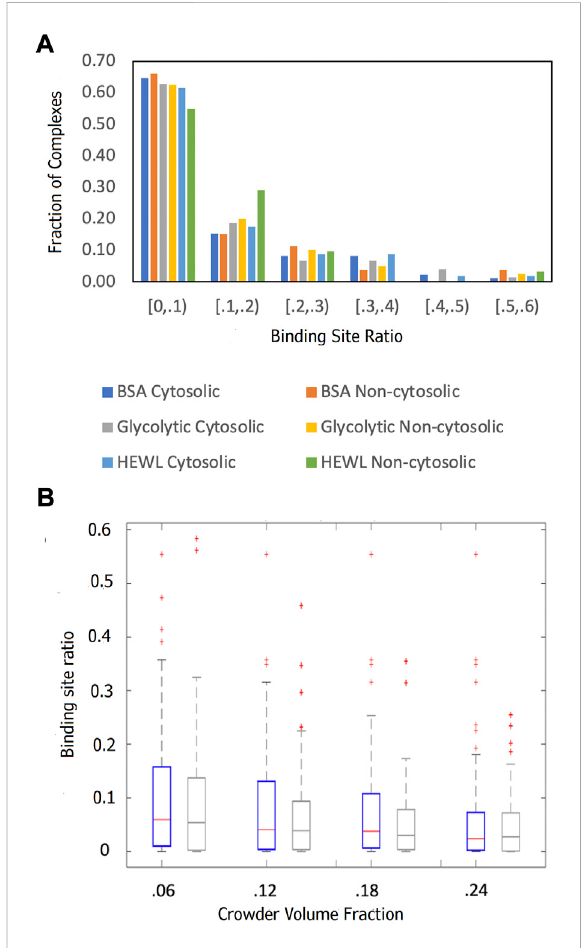
FIGURE 8 Comparison of the funnel sizes of cytosolic and non- cytosolic proteins. The data is based on 89 cytosolic and 52 non- cytosolic proteins. The funnel size for a complex i is estimated by the binding site ratio η (i) (Eq. 1). (A) The distributions of η (i) at 0.06 crowder volume fraction for three different crowder systems (see legend). (B) Box-and-whiskers representations of η (i) distributions for cytosolic (blue) and non-cytosolic (gray) proteins at different BSA crowder volume fractions.